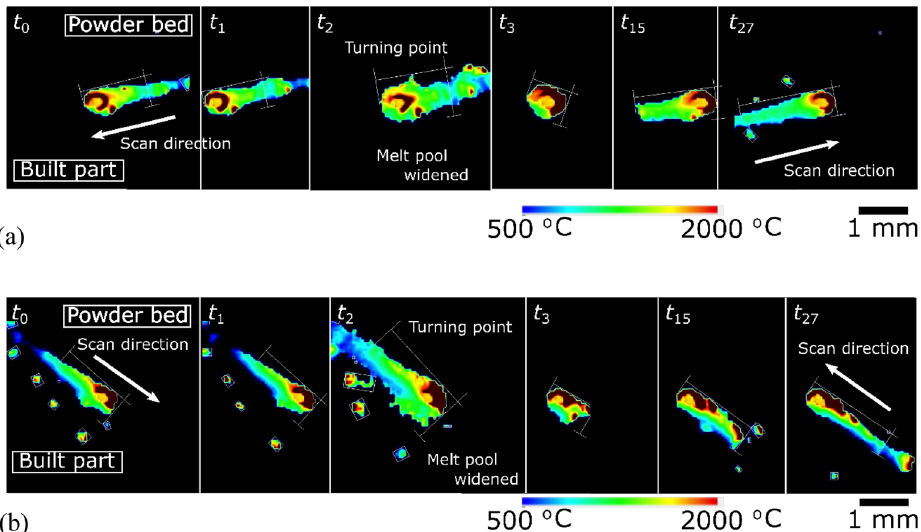
Figure 4. Sequential images of the melt pool behavior at the laser turning point of the ( a ) 1250th layer and ( b ) 1254th layer of the specimen fabricated at the condition ( P = 200 W, v = 665 mm/s, h = 0.1 mm, z = 0.05 mm, and E = 30.1 J/mm 3 ). Time t n is n × 100 ns after the first frame; n = 0